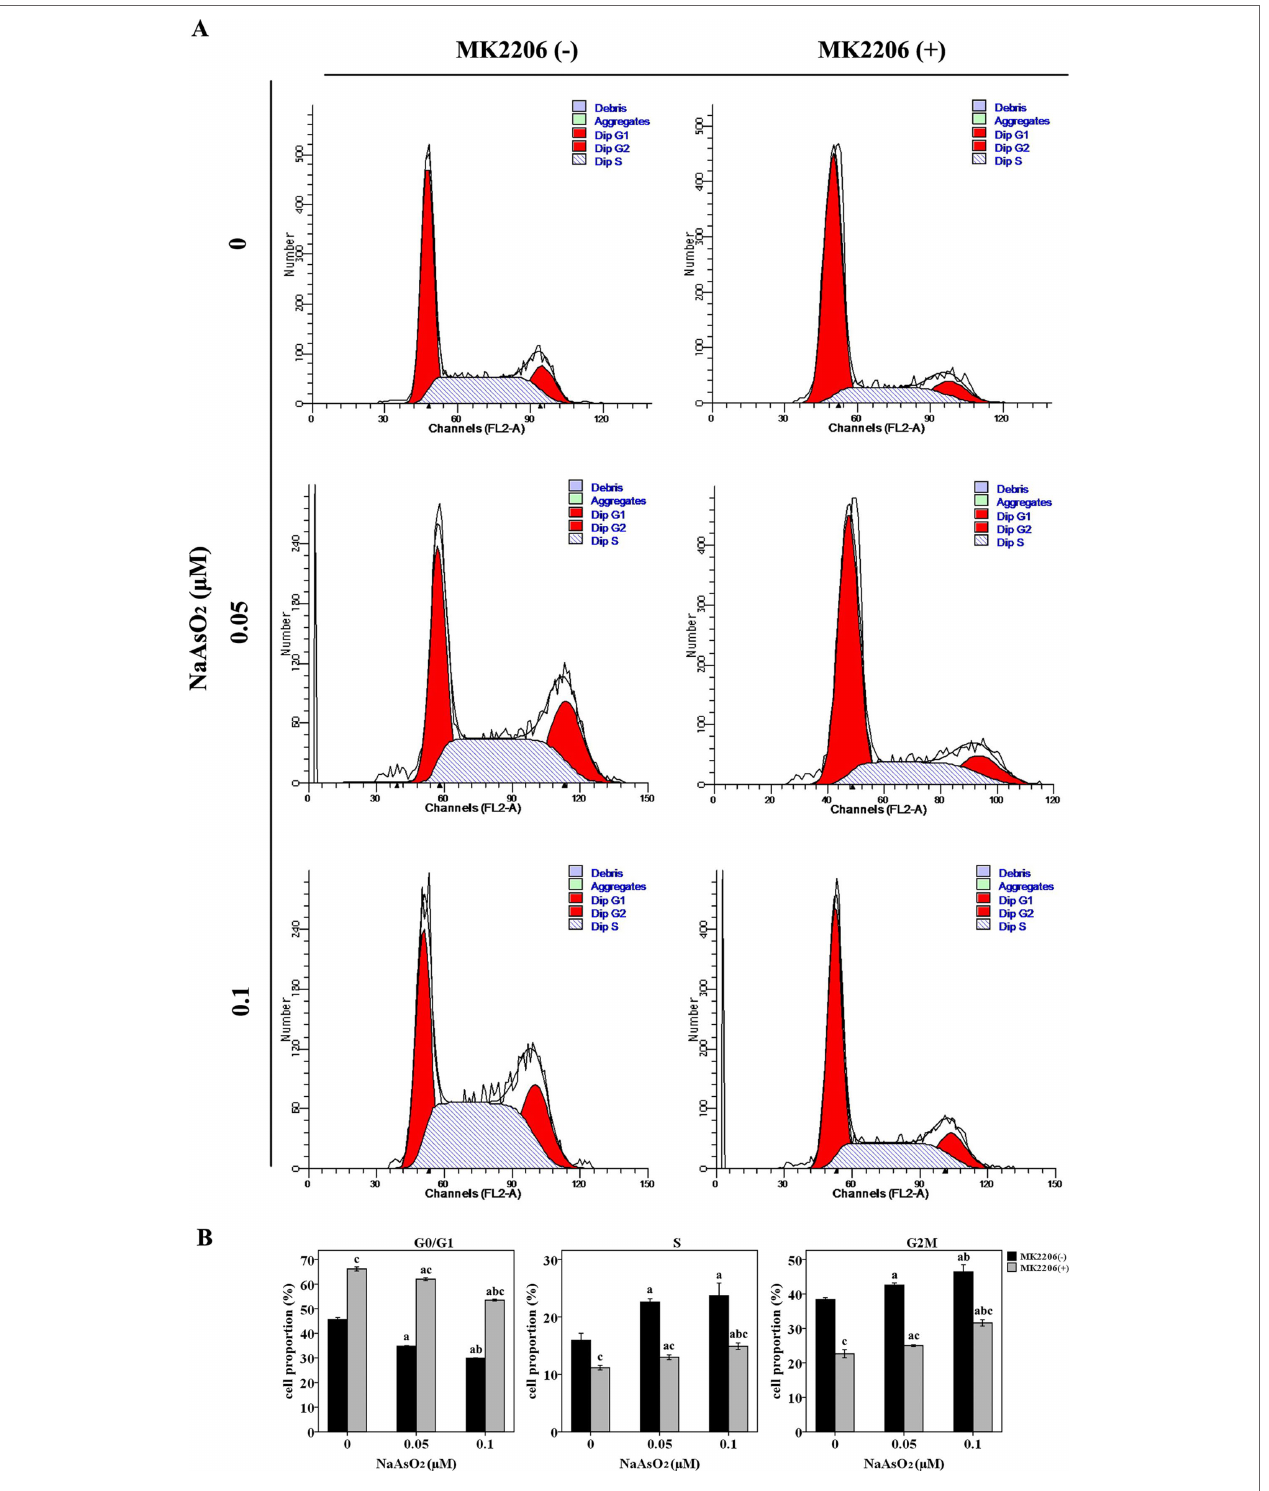
FIGURE 3 | Repeated low-dose NaAsO 2 exposure promoted HaCat cell cycle progression from G0/G1 to S/G2M phase. Cell cycle was detected by the standard propidium iodide method. (A) Cell cycle analysis evaluated by flow cytometry. Images are the representative results of three separate experiments. (B) Quantitative graphs of the cell proportions divided by cell cycle ( n = 3). NaAsO 2 exposure resulted in decreased proportion of G0/G1 phase, but increased proportions of S and G2M phases, no matter in the presence or absence of MK2206. NaAsO 2 induced cell cycle progression from G0/G1 to S/G2M phase could be attenuated by the treatment of MK2206. Significant difference was defined as p less than 0.05. a, vs. the corresponding 0 μM group; b, vs. the corresponding 0.05 μM group; c, vs. the MK2206(-) group of the same NaAsO 2